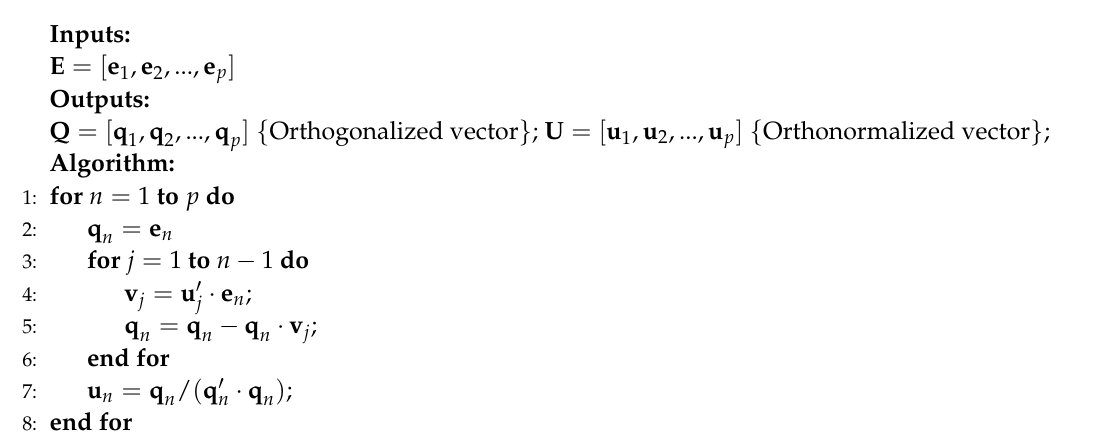
Algorithm 1 Modified version of the Gram–Schmidt